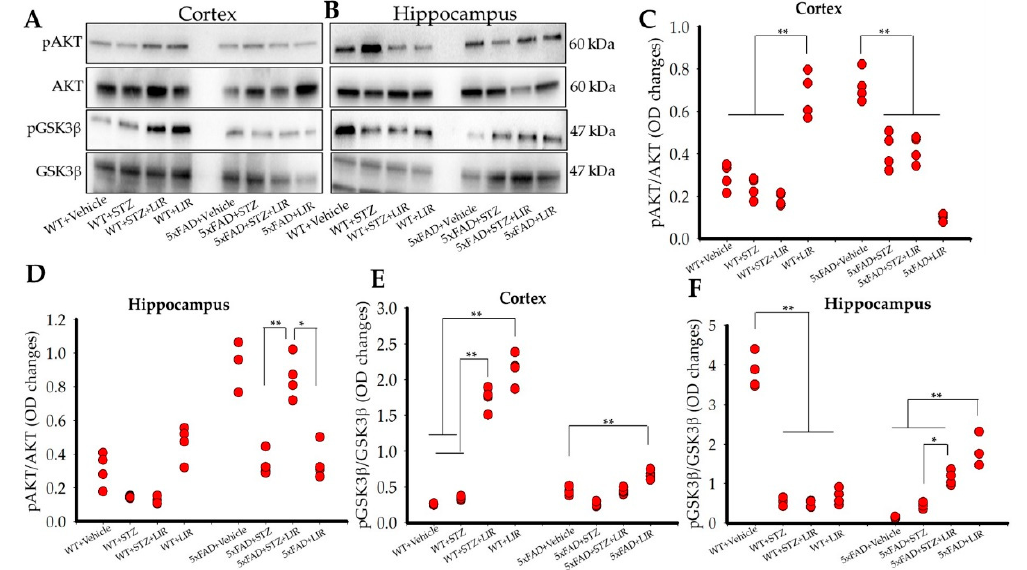
Figure 6. pAKT and pGSK3 β protein levels in the cortical and hippocampal regions of both WT and 5xFAD mice. Following LIR treatment, WT and 5xFAD mice ( n = 3 from each group) were sacrificed via cervical dislocation and their fresh brains were immediately collected and homogenized for Western blot analysis. ( A , B ): Representative Western blot bands for pAKT and pGSK3 β in both cortical and hippocampal regions of WT and 5xFAD mice. ( C , D ): Histograms showing densitometric quantification of pAKT, normalized with GAPDH and AKT in cortex and hippocampal regions of the brain respectively. ( E , F ): Histograms showing densitometric quantification of pGSK3 β , normalized with GAPDH and GSK3 β in the cortical and hippocampal regions of WT and 5xFAD mice brain tissue. * p < 0.05. ** p < 0.01.